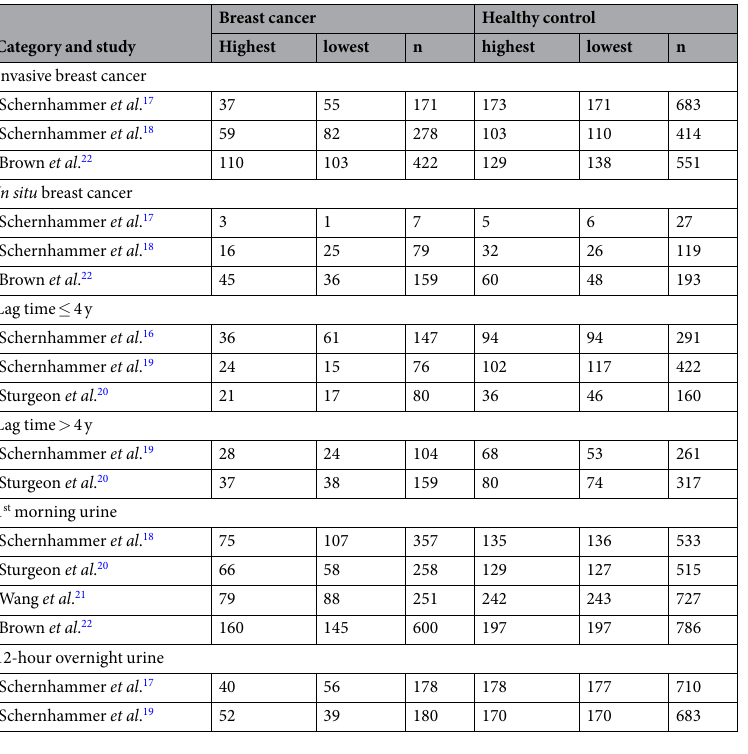
Table 4. Case number in the highest and lowest levels in the breast cancer and healthy control groups.